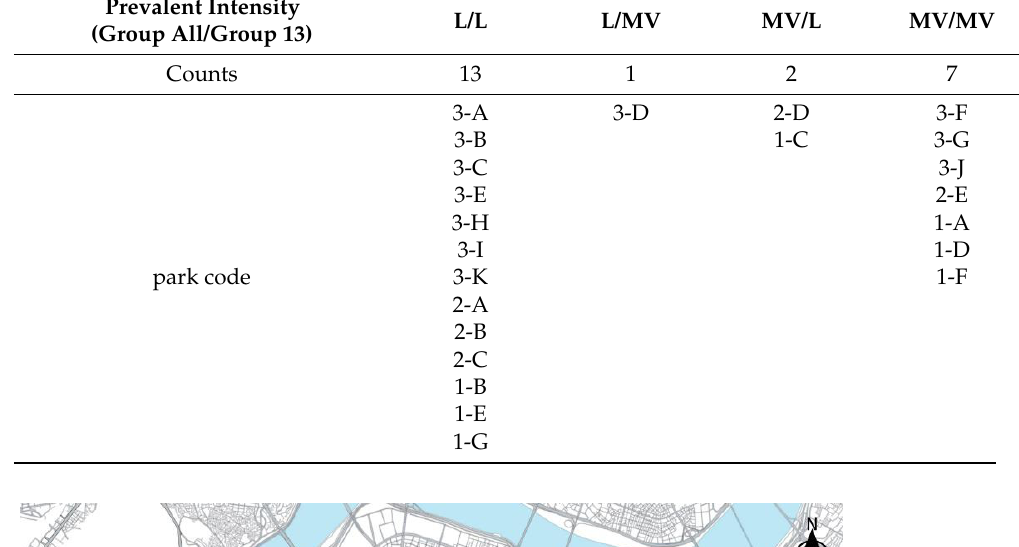
Table 8. Parks grouped by the prevalent intensity of Group All and Group 13.